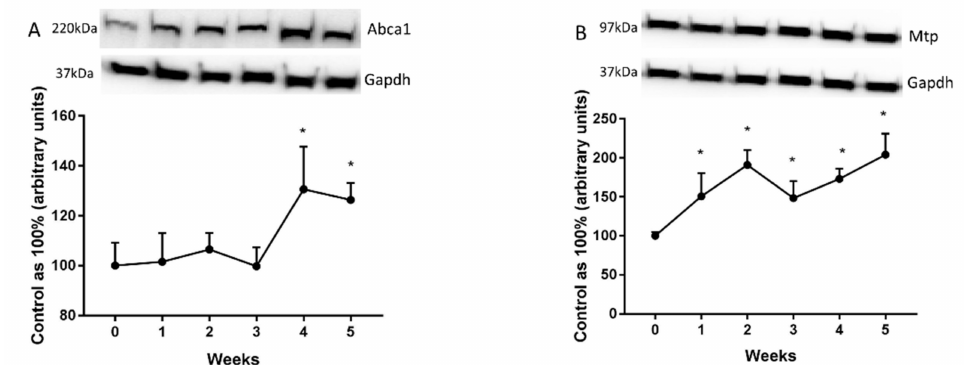
Figure 3. Representative Western blots showing the expression of proteins involved in fatty acids transport outside the cell, i.e., ATP-binding cassette transporter A1 (Abca1) ( A ) and microsomal triacylglycerol transfer protein (Mtp) ( B ) in the liver homogenates from control group (0 week) and HFD group at the end of each experimental week (1, 2, 3, 4, and 5). The protein expression was measured using Western blot method as it was described in ‘Materials and methods’ section. The data are expressed as the mean ± S.D. and are based on six independent determinations ( n = 6). * p < 0.05 significant di ff erence vs control group (0 week). The samples derived from the same experiment and blots were processed in